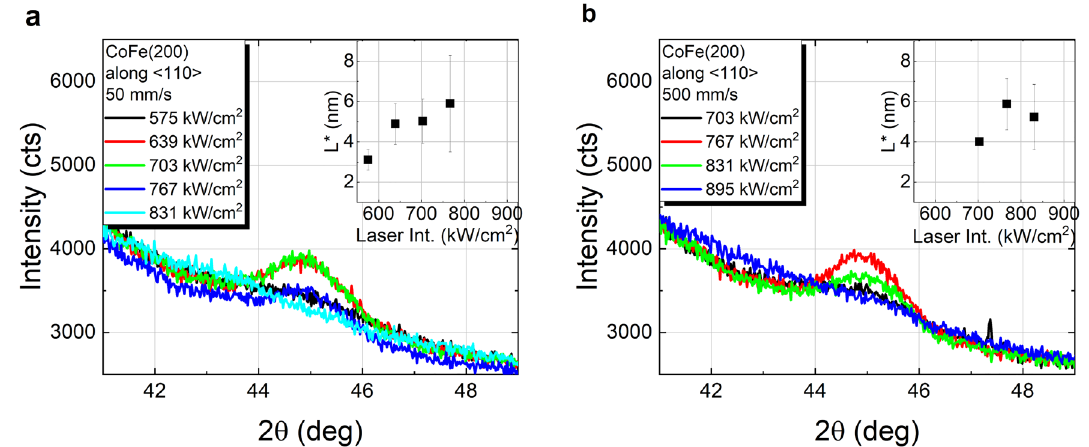
Figure 6. XRD off-specular θ–2θ scans (sample tilt of χ = 45°) measuring the (110) peak of CoFe(200) crystallites of Co 40 Fe 40 B 20 capped with MgO annealed by laser irradiation at ( a ) 50 mm/s and ( b ) 500 mm/s scanning speed. Coherence lengths along the <110> direction, L *, in dependence of the laser intensities are plotted in the